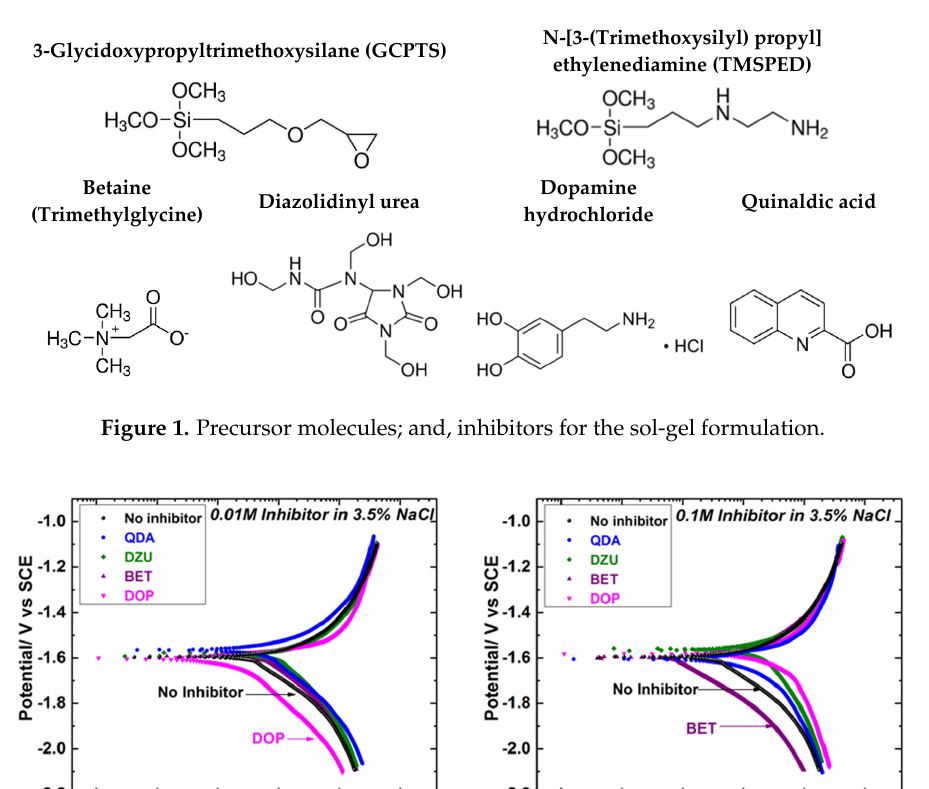
Figure 2. PDS plots of Mg AZ31 in 3.5 wt % electrolyte, containing ( a ) 0.01M inhibitor and ( b ) 0.1 M inhibitor.